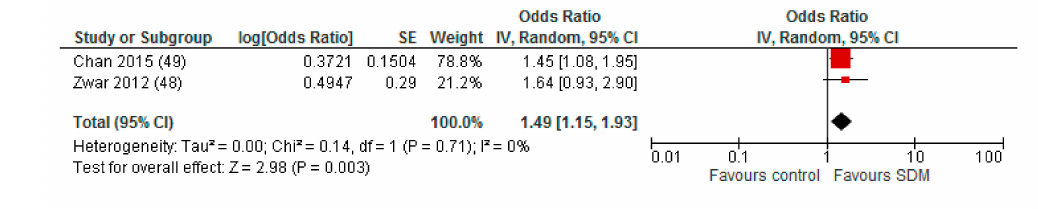
Figure A1. Subgroup: Deliberation by physicians.